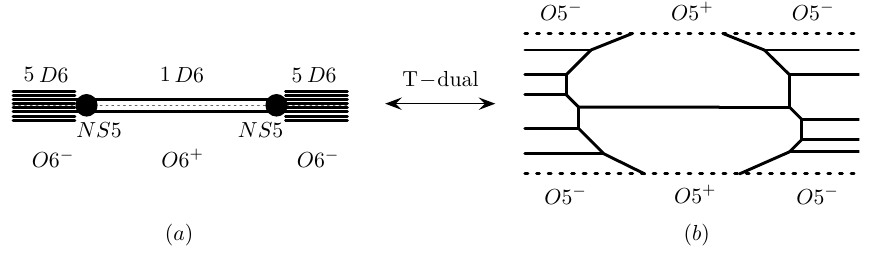
Figure 3 . (a): A Type IIA brane configuration for 6d Sp(1) gauge theory with 10 flavors and a tensor. (b): A Type IIB brane configuration which is T-dual of (a).